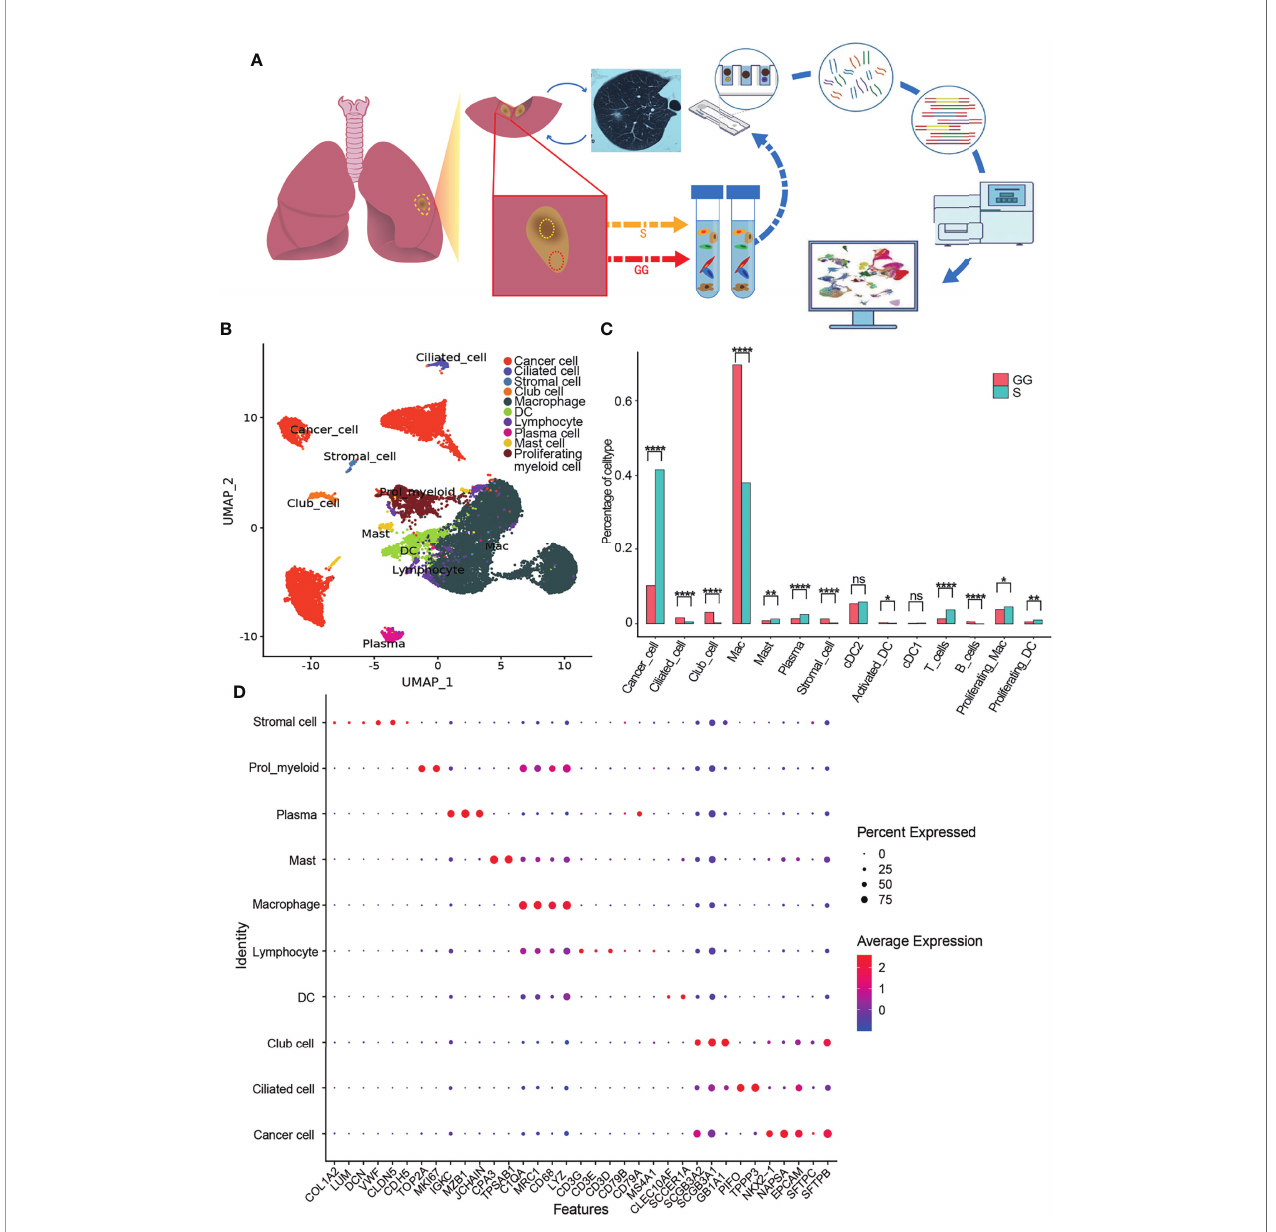
FIGURE 1 | Sampling, sequencing, and clustering from mGGO. (A) Sampling and sequencing work fl ow. (B) Cell atlas of mGGO shown by UMAP; each dot corresponds to a single cell, and clusters are labeled with names and colored. (C) Differences of cluster proportion between S component and GG component of mGGO; chi-squared test was used for analysis. (D) Bubble plot shows mean expression level of marker genes (x-axis) for each cell type (y-axis); dot size, proportion of cells expressed the gene; dot color, average expression level among cells. mGGO, mixed ground-glass opacity; UMAP, Uniform Manifold Approximation and Projection; S, solid; GG, ground glass. * P<0.05, ** P<0.01, **** P<0.0001, ns non-signi fi